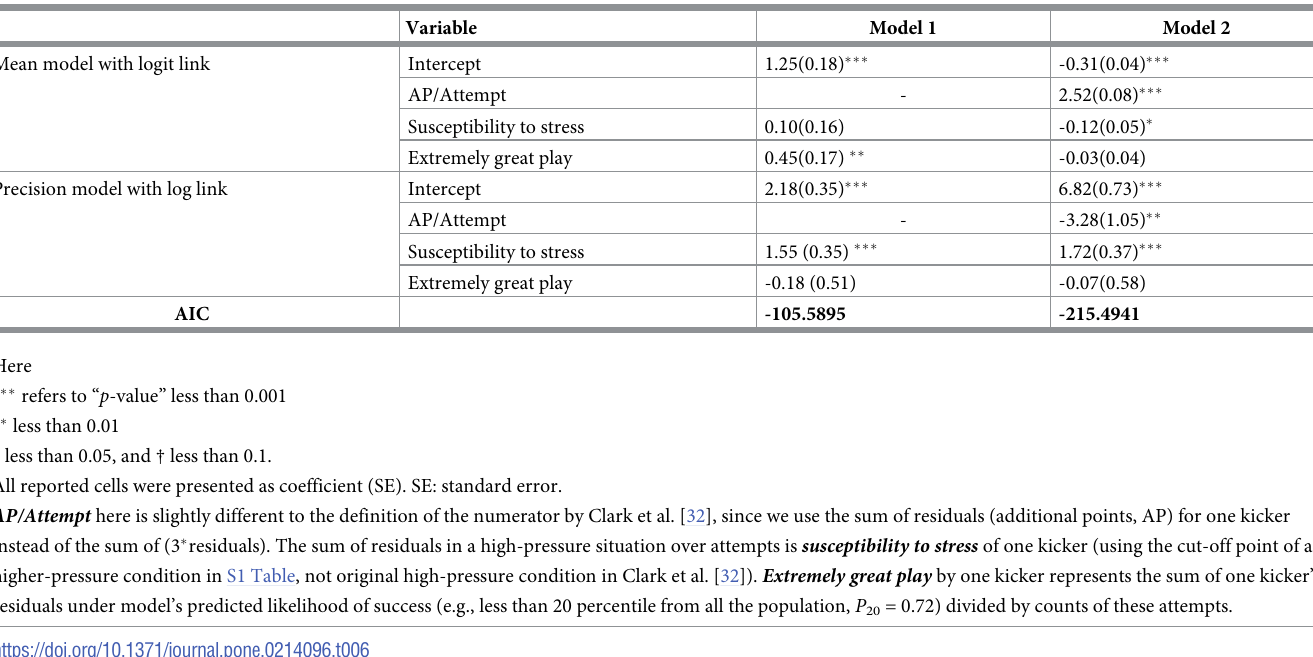
Table 6. Beta regression